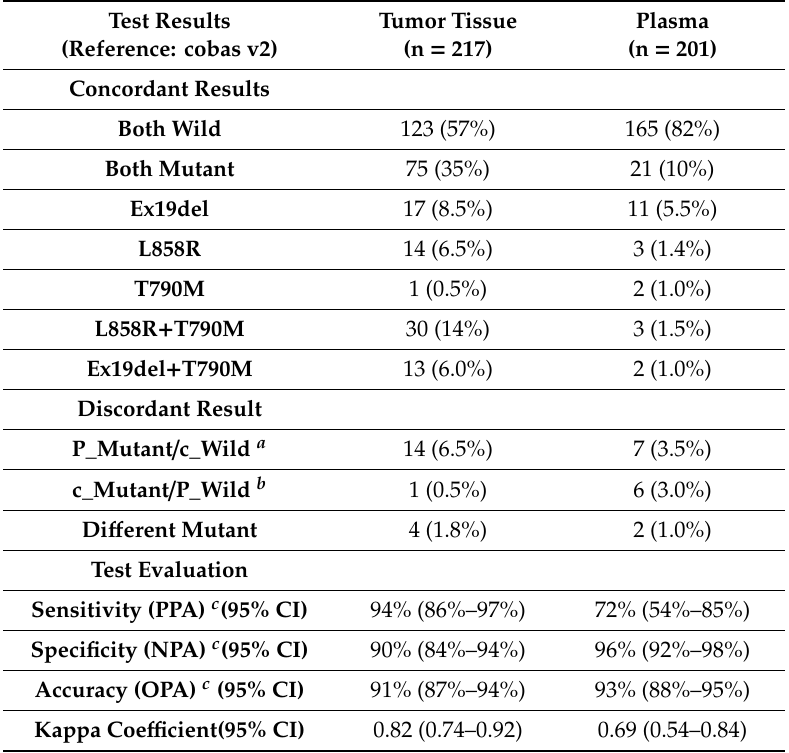
Table 2. Concordance of two EGFR mutation tests in tumor tissue and plasma